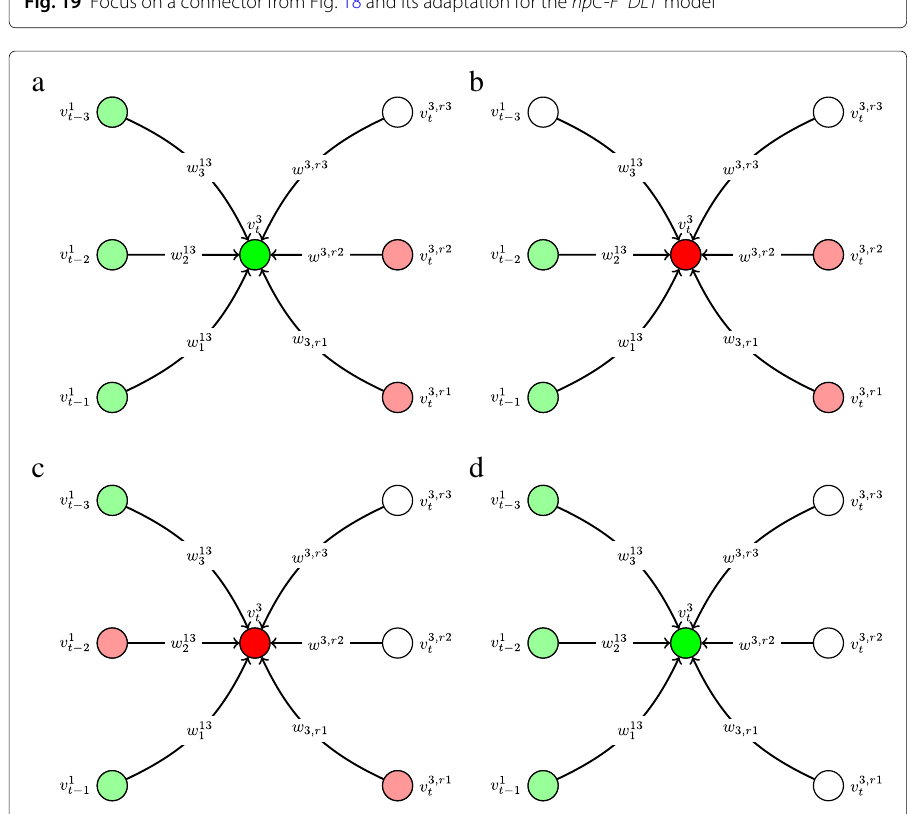
Fig. 20 Possible configurations for the connector in Fig.